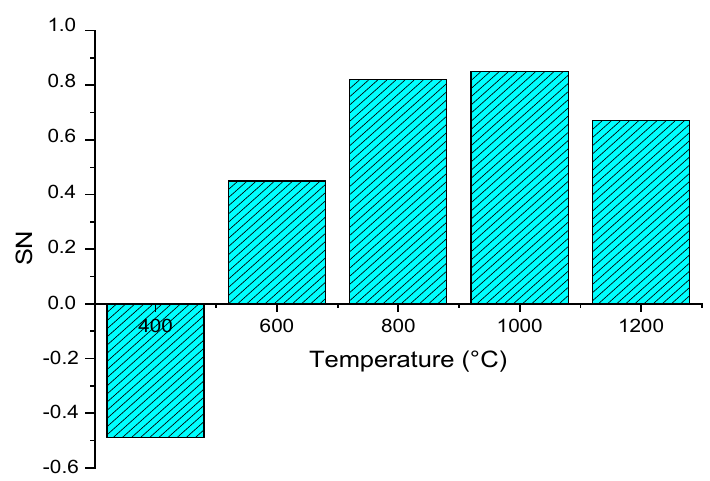
Figure 3. Effect of gasifier temperature on stoichiometric number (SN) Figure 3. E ff ect of gasifier temperature on stoichiometric number